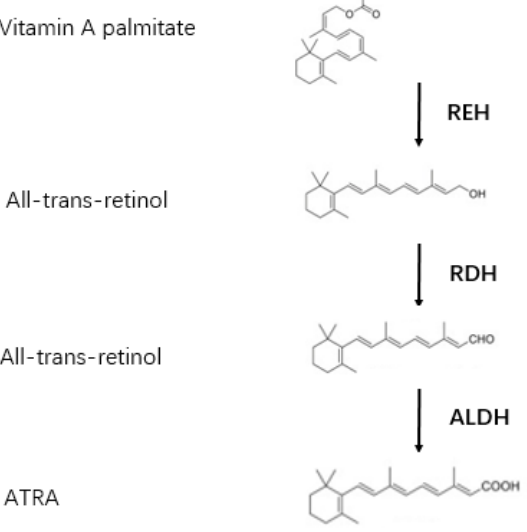
Figure 1. The process of converting of Vitamin A to ATRA. RARs are members of the steroid/vitamin D/thyroid hormone receptor family, the pleiotropic effect of ATRA is mediated through its combination with RARs [18], and regulates many biological functions, such as embryonic development, organogenesis, homeostasis, vision, immune function, and reproduction [25]. Like most nuclear receptors (NRs), RARs have the function of the dimer. RARs cooperate with the retinoid receptor (RXR) to form heterodimers, which are the main regulators of human gene expression and an important drug target [26]. RARs and RXRs are modular proteins composed of several domains, the most notable being a DNA binding domain (DBD) and a C-terminal